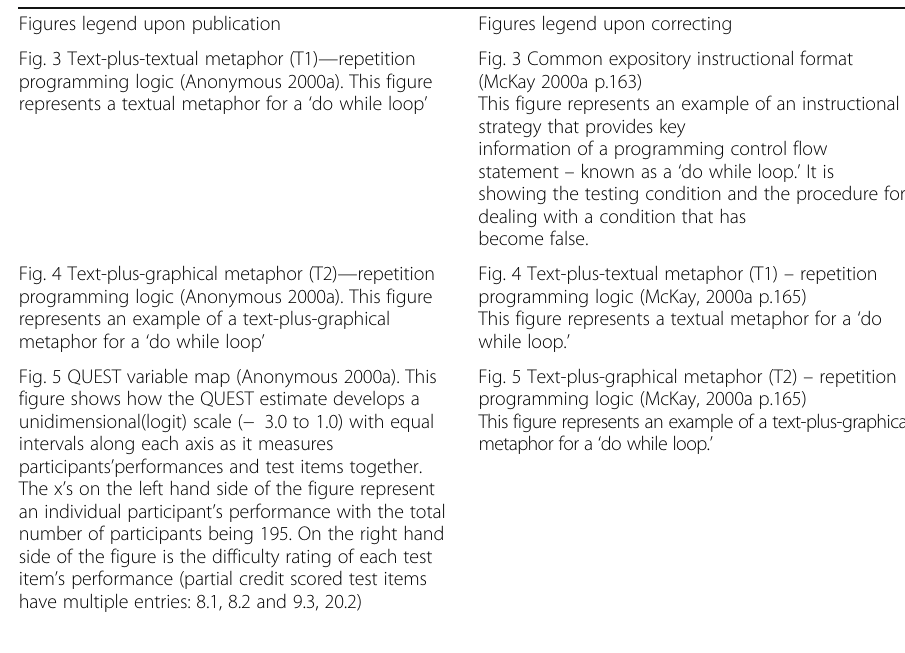
Fig. 3 Text-plus-textual metaphor (T1) — repetition programming logic (Anonymous 2000a). This figure